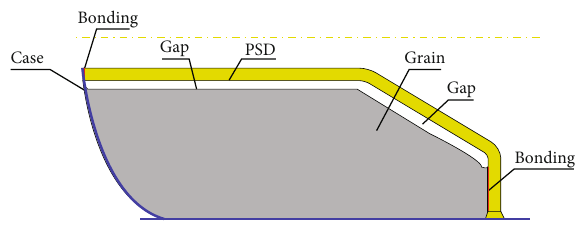
Figure 4: Simpli fi ed physical model of second-pulse combustion